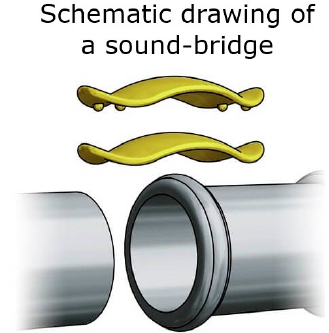
Figure 1. Picture of the upper part of a tenor saxophone with a “Gold-plated sound bridge” mounted to the connection-point of mouthpiece and S-bow according to the instructions of the manufacturer of the sound bridge. Source of picture: lefreQue BV/Netherlands.